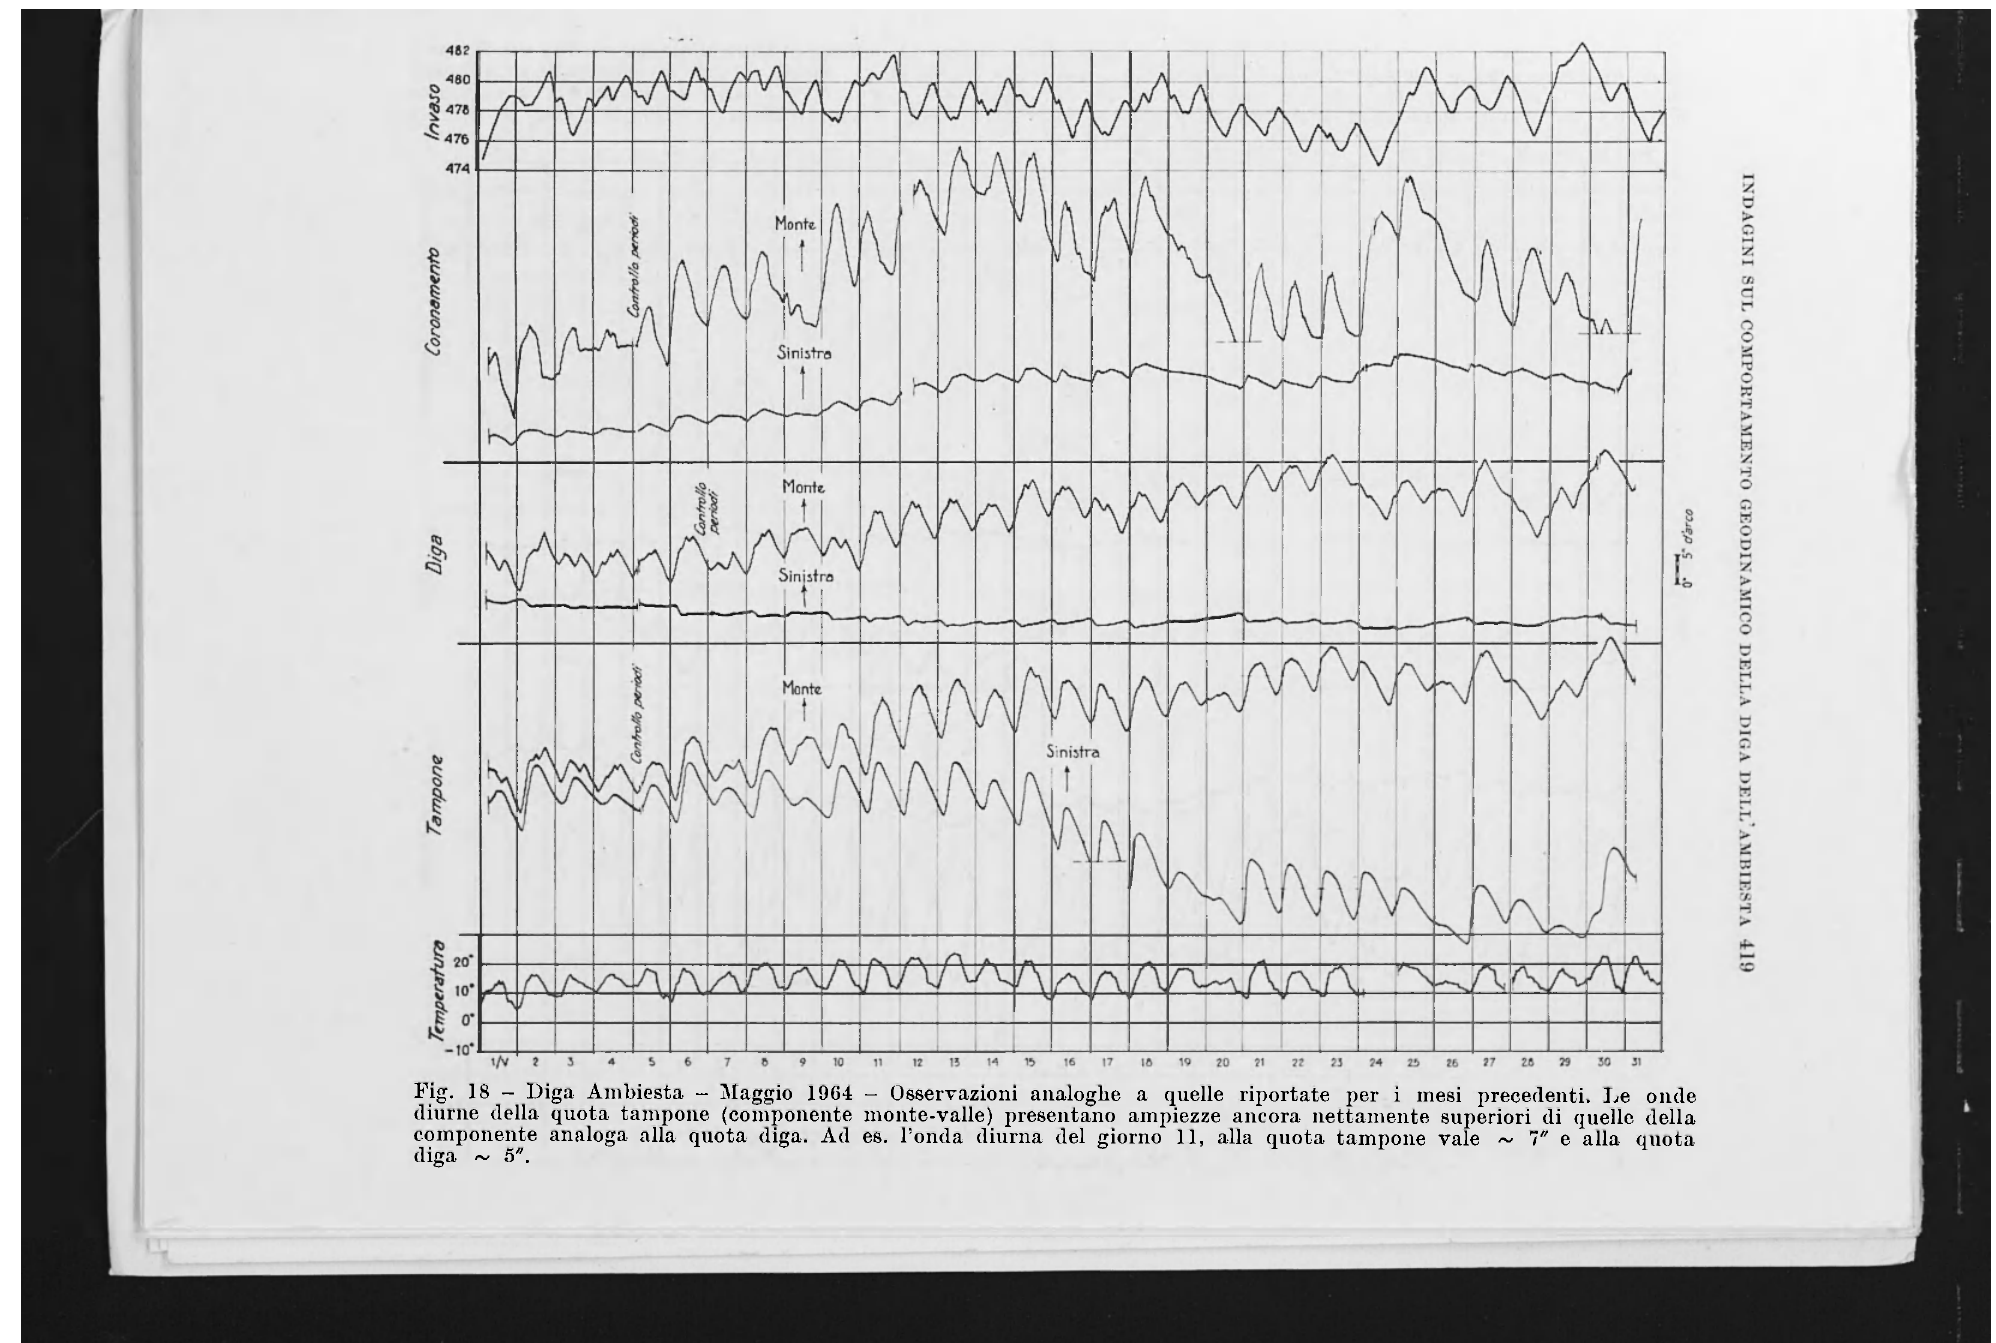
Fig. 18 - Diga Ambiesta - Maggio 1964 - Osservazioni analoghe a quelle riportate per i mesi precedenti. Le onde diurne della quota tampone (componente monte-valle) presentano ampiezze ancora nettamente superiori di quelle della componente analoga alla quota diga. Ad es. l'onda diurna del giorno 11, alla quota tampone vale ~ 7" e alla quota diga ~